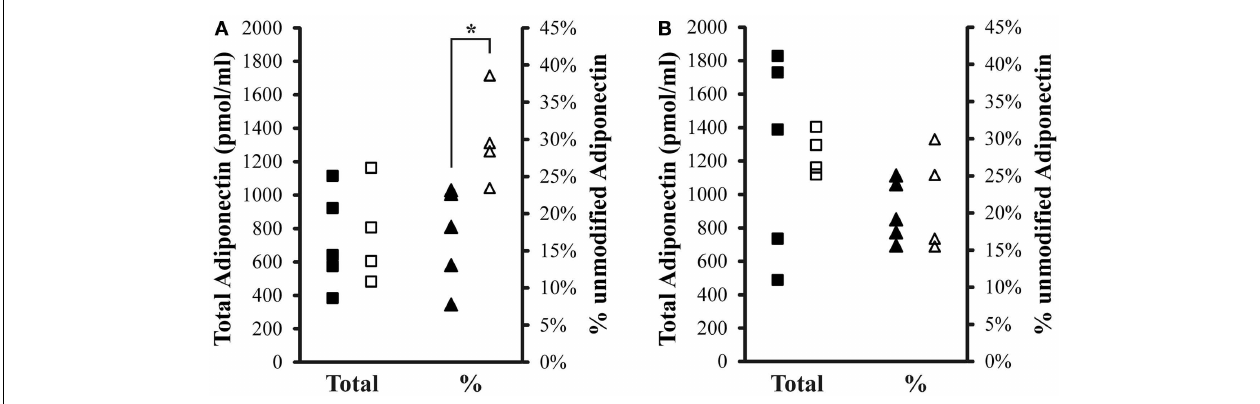
percent unmodified adiponectin. Solid symbols are controls and hollow symbols are iron overload cases. An “*” indicates significance difference ( p < 0.05) when comparing the